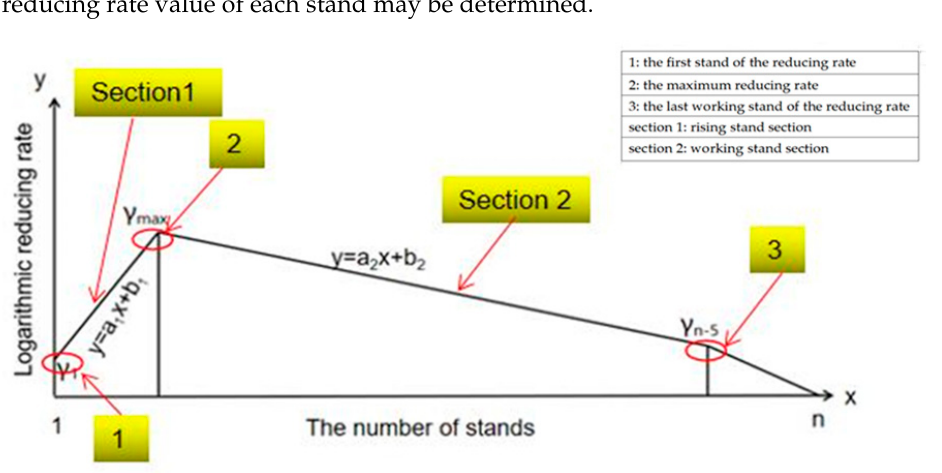
Figure 4. Basic three-point and two-section method.